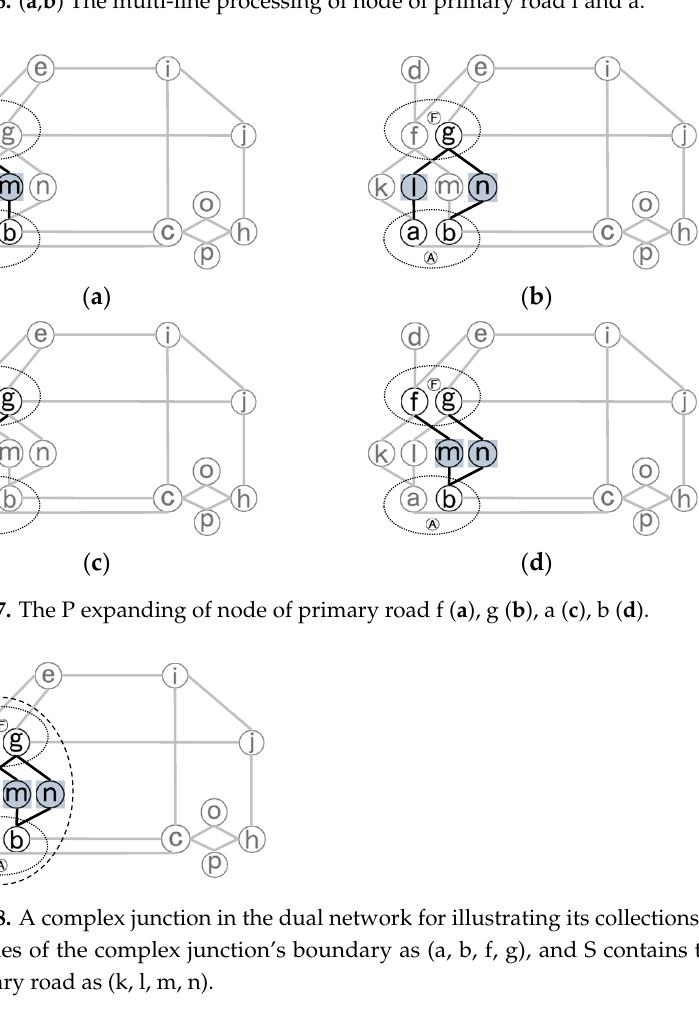
Figure 8. A complex junction in the dual network for illustrating its collec- tions of nodes . P contains the nodes of the complex junction’s boundary as (a, b, f, g), and S contains the interior nodes of secondary road as (k, l, m, n). (9) Global recursion: repeat step 2–8 to find more complex junc- tions in the road Figure 7. The P expanding of node of primary road f ( a ), g ( b ), a ( c ), b ( d ). (7) Local recursion: repeat step 5–6 till all nodes in both P and S are expanded; (8) Collecting results: now a complex junction j has just been iden- tified, for which P contains its boundary primary roads and S contains its interior secondary roads. Mark the nodes in S as processed in SG,